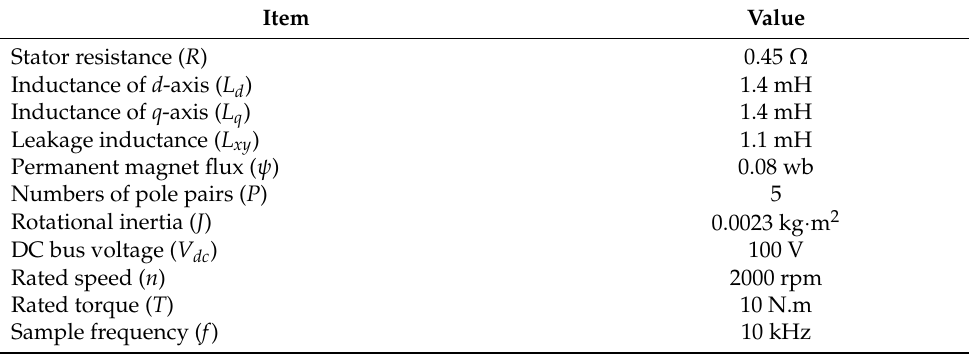
Table 1. Key parameters of the experimental